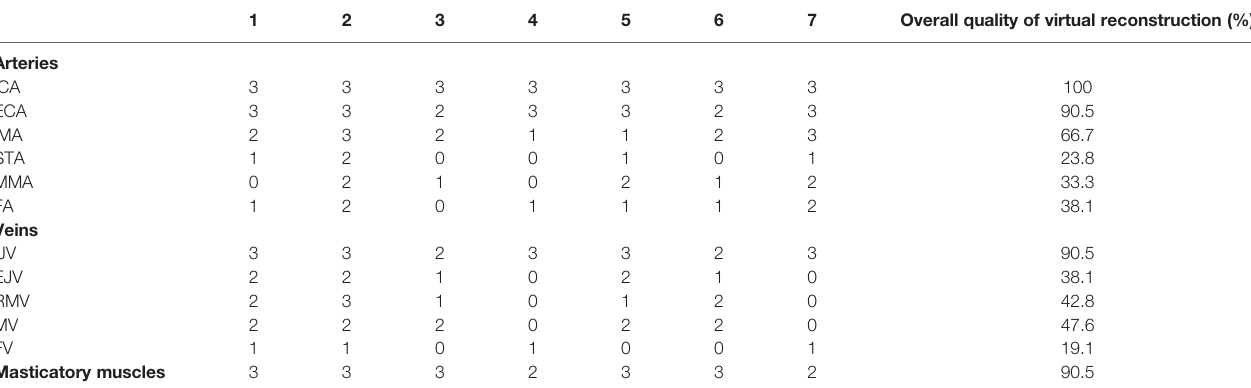
TABLE 2 | Quality scores de fi ning the computerized reconstruction for vascular and muscular